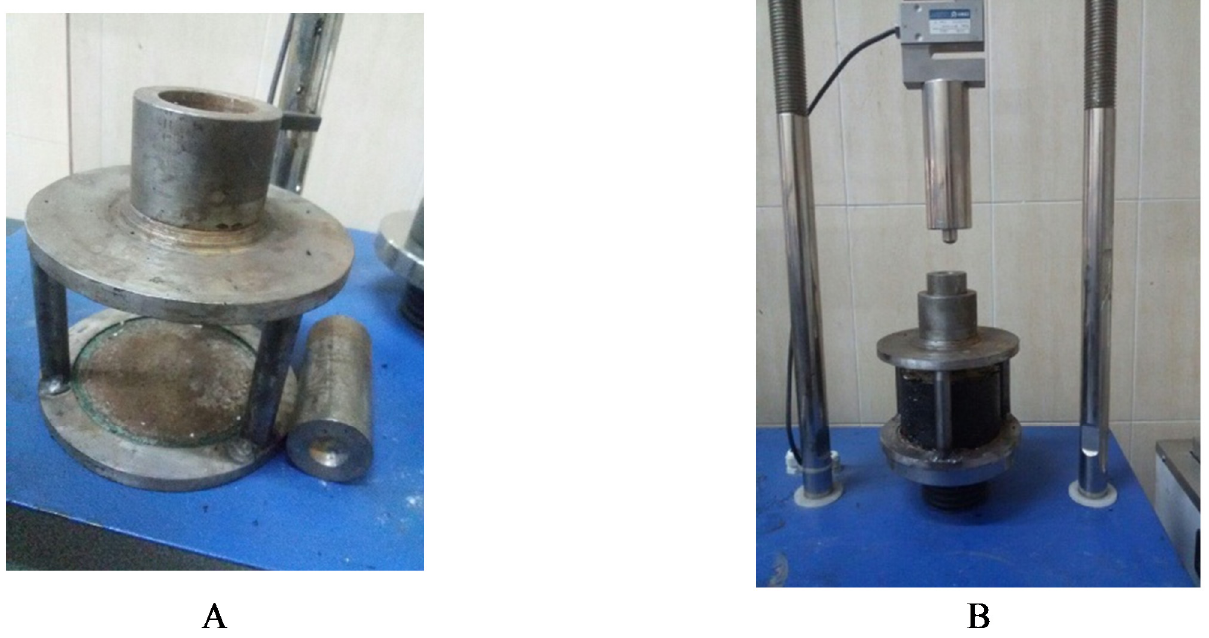
Figure 3. ( A ) Kim test mold and ( B ) typical failure modes.3.4. Self-healing Tests.